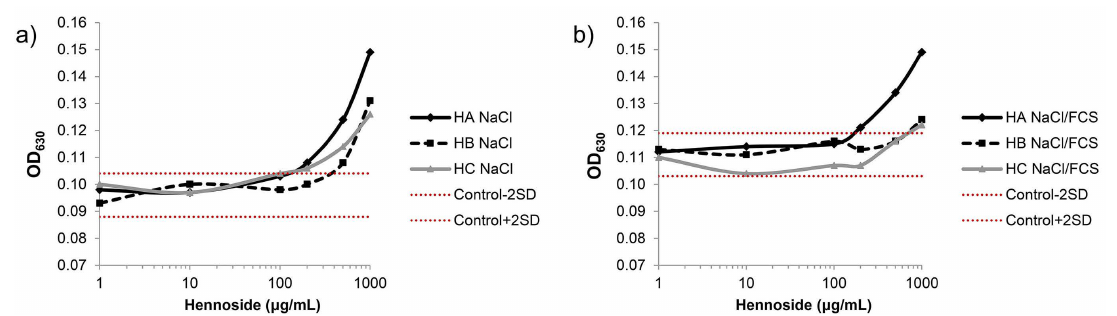
Figure 6. Hennoside-induced methemoglobin formation. Methemoglobin measurement based on an increase in OD 630 values. ( a ) diluent 0.9% NaCl (NaCl); ( b ) diluent 0.9% NaCl containing 10% FCS (NaCl/FCS). Dotted red lines represent mean value ± 2SD range for the control, i.e., spontaneously formed methemoglobin.